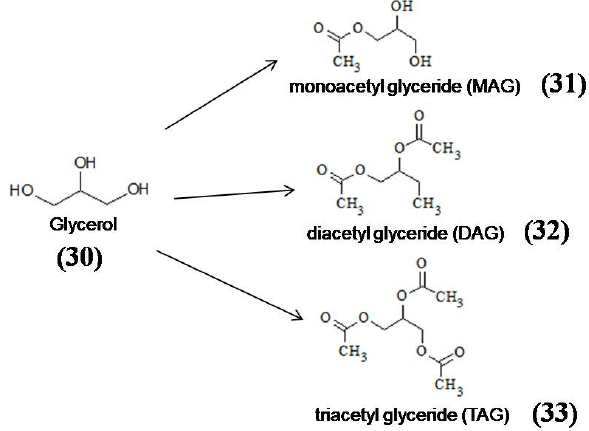
Figure 6. Esterification of glycerol into satins.